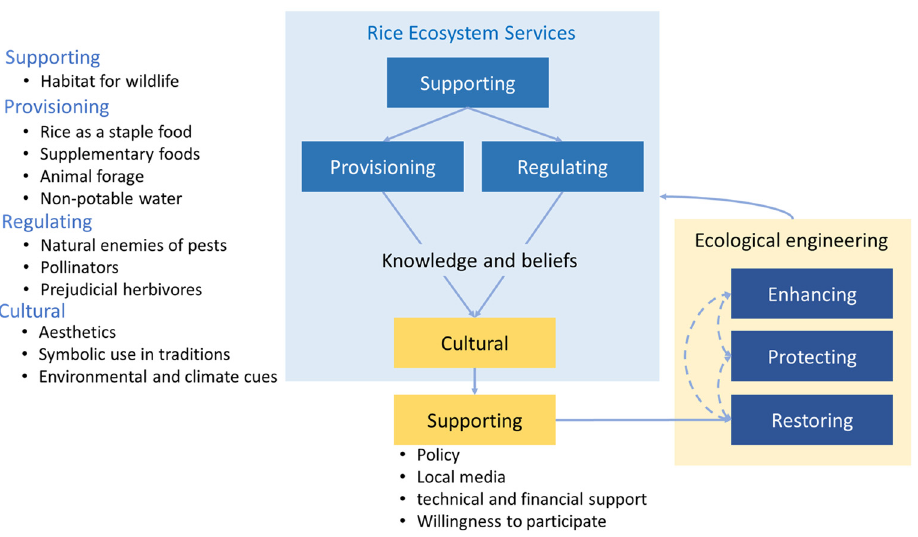
Figure 2. Linkage between the ecosystem services provided by tropical rice fields (indicated in the blue frame) and ‘human services to the rice ecosystem’ (indicated in the yellow frame) as mediated through policy, media and culture (supporting services to ecosystems (indicated by an orange rectangle)). The schematic presents the linkages as part of a positive-feedback system largely driven by farmers’ appreciations of ecosystem services (knowledge and beliefs). Some of the supporting, provisioning, regulating and cultural services mentioned by farmers in this study are also listed.